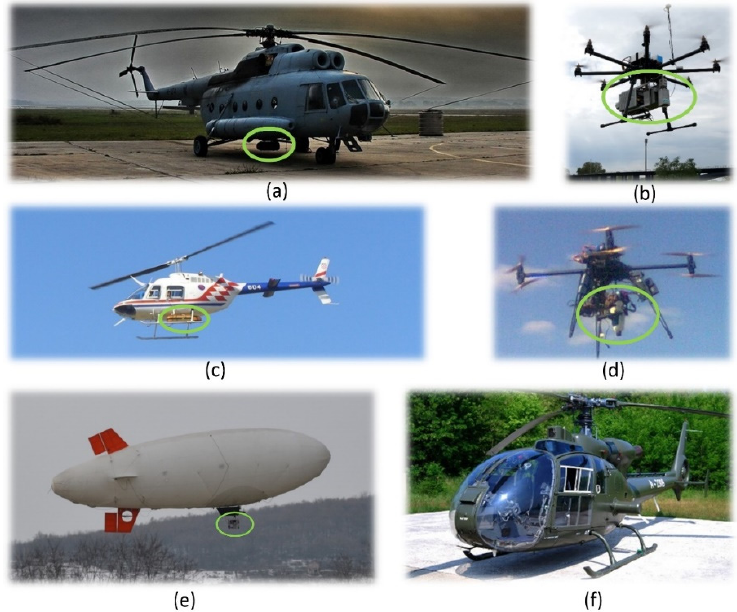
Figure 3. Platforms for aerial data acquisition system of AIDSS and sensor pods (in the green ellipses) on ( a ) Mi-8 helicopter, ( b ) remotely piloted aircraft system (RPAS) 8 ZERO, ( c ) Bell-206helicopter, ( d ) RPAS X8 MK, ( e ) blimp, and ( f ) Gazela helicopter.